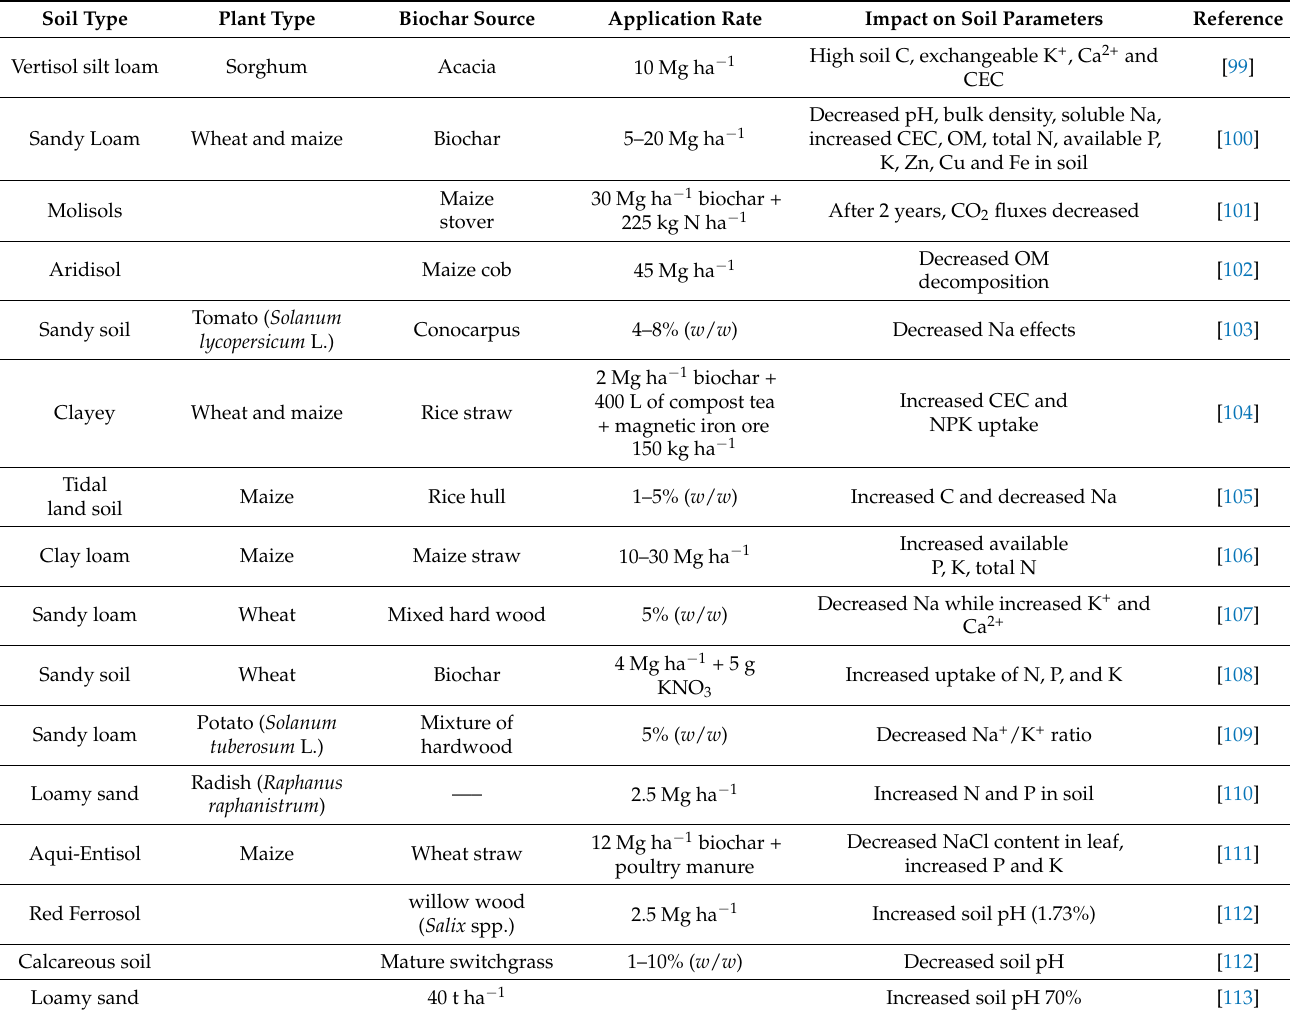
Table 2. Application of biochar and soil